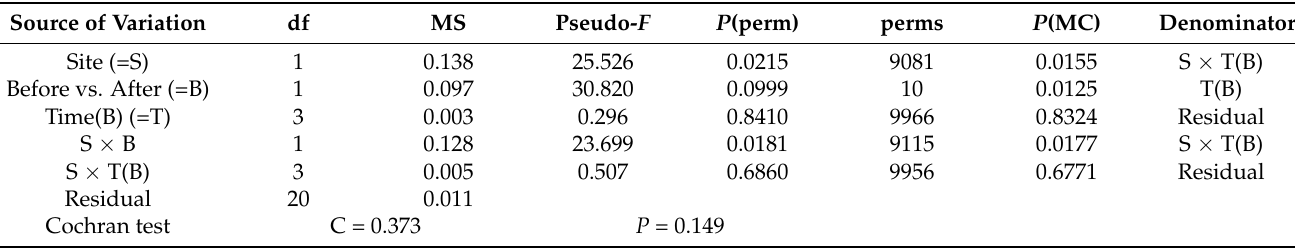
Table 7. PERMANOVA on Pielou’s evenness index ( J’ ) of benthic assemblages of Treatment and Control sites at Before (T1, T2) and three After (T3–T5) the bioremediating action. Cochran’s C-test was used before each analysis to check for homogeneity of variance.